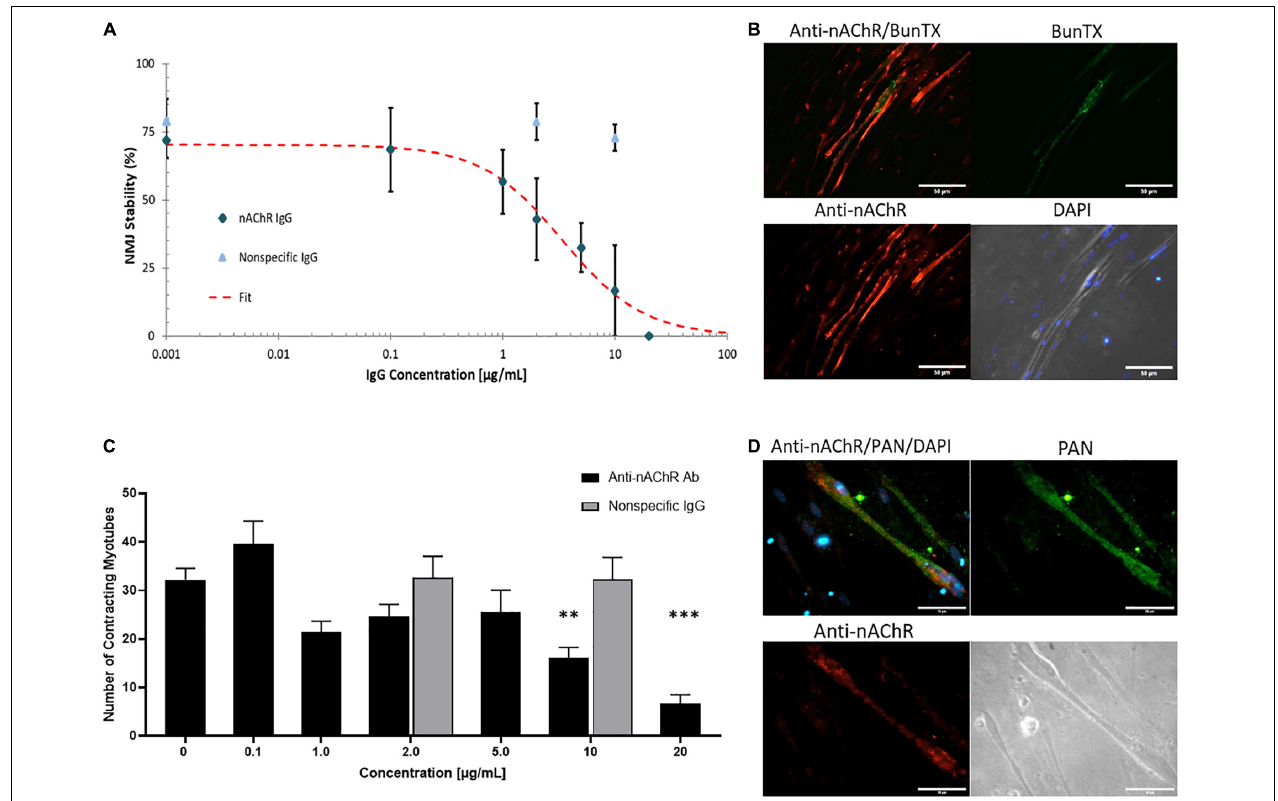
FIGURE 3 | Anti-nAChR IgG effects on the NMJ. (A) A dose response curve established from NMJ stability of SKM dosed with the anti-nAChR Ab (diamond) from 0 to 20 µ g/mL resulting in an IC50 of 3.4 µ g/mL ( N = 2, 3–10 replicates). A non-specific IgG antibody (triangle) did not significantly alter NMJ stability at 2 and 10 µ g/mL ( N = 2, 7–8 replicates). (B) ICC images of SKM revealing the antibody-antigen complex with the binding of anti-nAChR Ab (red channel) to the cell surface near the endplate marked by BunTX (green channel), overlay of red and green channels (upper left) and phase image with DAPI (lower right). Scale bars = 50 microns. (C) The number of contracting SKM under direct stimulation at dosing concentrations from 0 to 20 µ g/mL ( N = 2, 3–10 replicates). Statistics: One-way ANOVA followed by Dunnett’s test (alpha = 0.05) ∗∗ p < 0.020, ∗∗∗ p < 0.002. (D) ICC images of SKM with anti-nAChR Ab staining (red channel), sodium channel (Pan, green channel), overlay of red and green channels (upper left) and phase image on lower right. Scale bars = 50